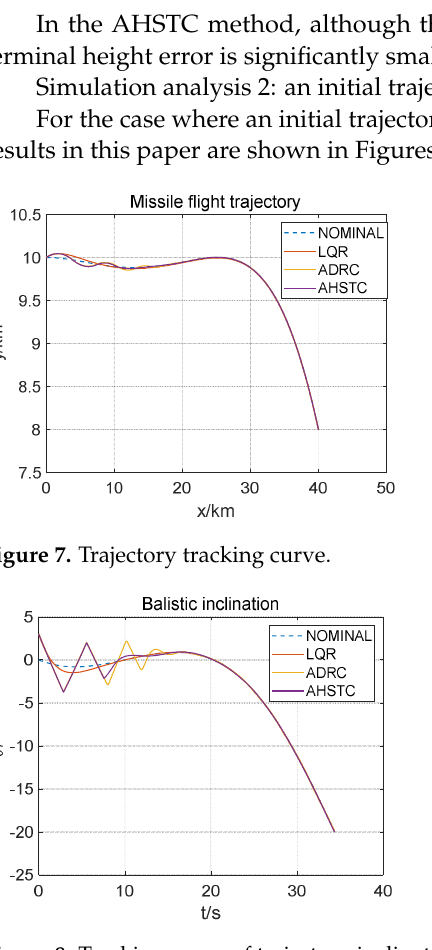
Figure 9. Control tracking curve.